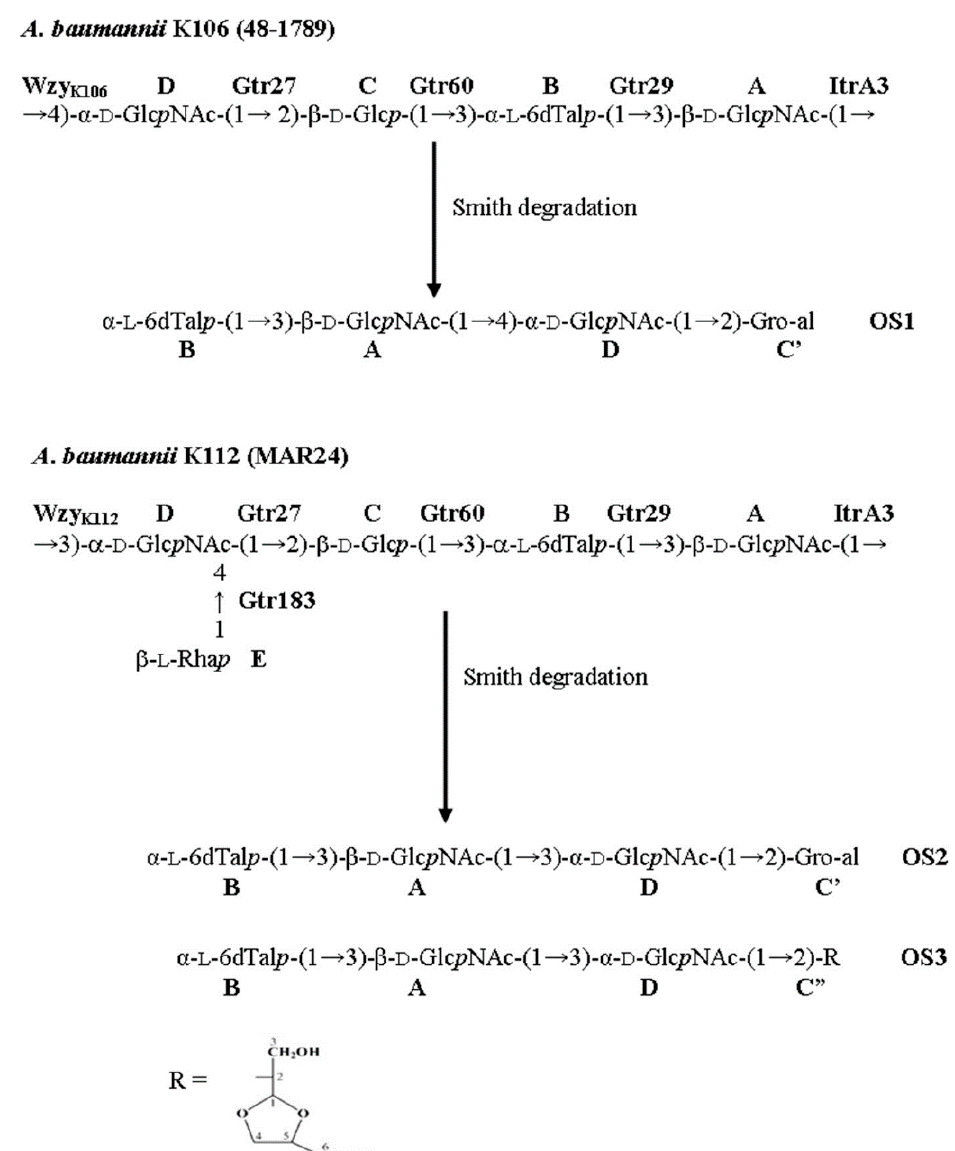
Figure 5. Structures of the capsular polysaccharides (CPSs) of A. baumannii , K106 (48-1789), K112 (MAR24), and oligosaccharides ( OS1 — OS3 ) derived by Smith degradation of the CPSs. Gro-al indicates glyceraldehyde. Glycosyltransferases are shown above or next to the linkage each is expected to form.